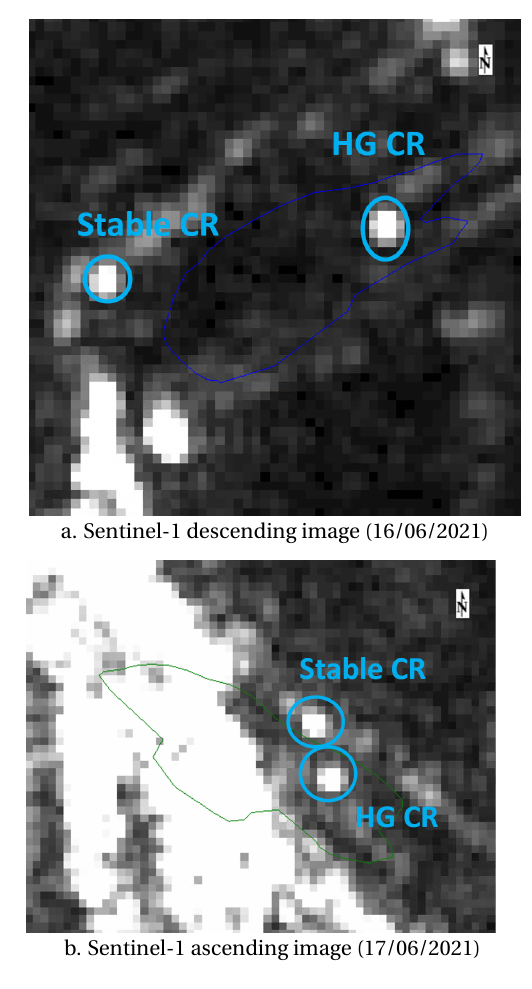
Figure 5. Visibility of the CRs on the HG (blue and green polygons) in Sentinel-1 images in SAR range-azimuth